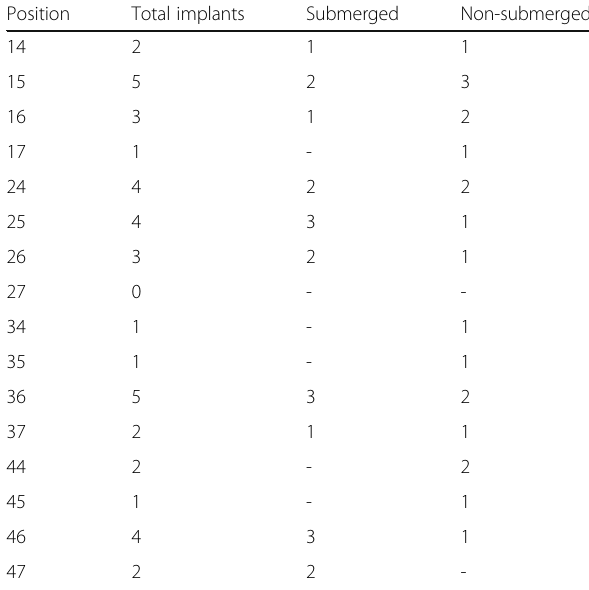
Table 2 Distribution of each implant in each group Position